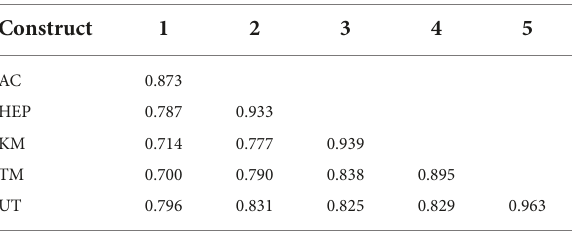
TABLE 4 Discriminant validity Fornell-Larcker criterion. TABLE 5 Coefficient of determination in the partial